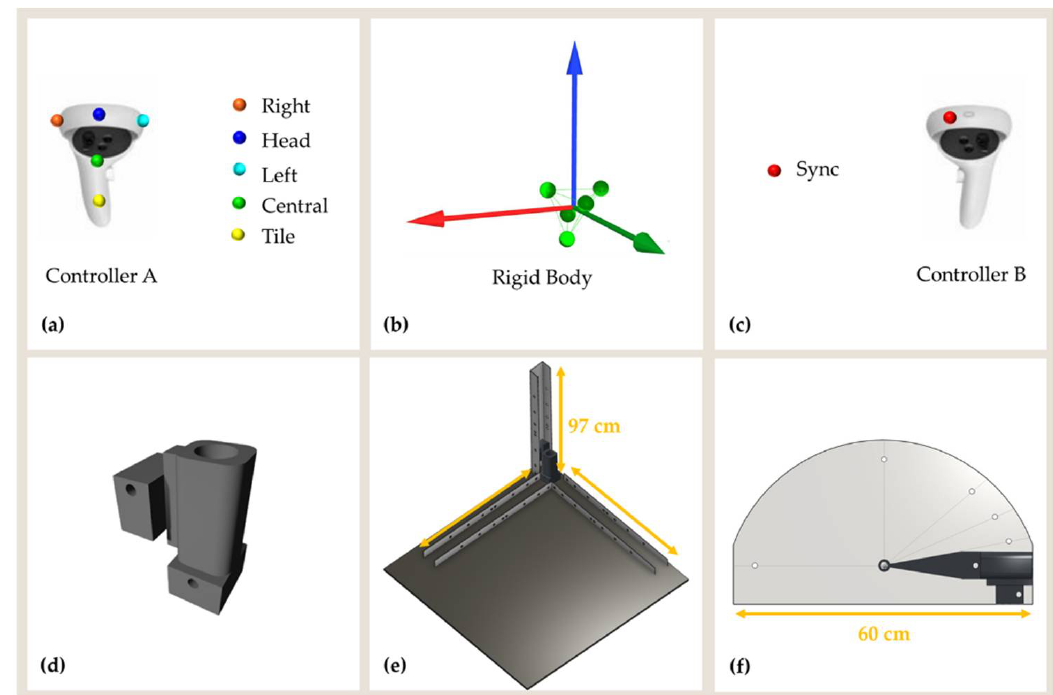
Figure 2. ( a ) Controller A and markers configuration used to define the ( b ) rigid body. ( c ) Controller B and position of the synchronization marker. Controller A was allocated in a ( d ) custom-made support designed to be easily moved on the structures for ( e ) translational and ( f ) rotational movements.